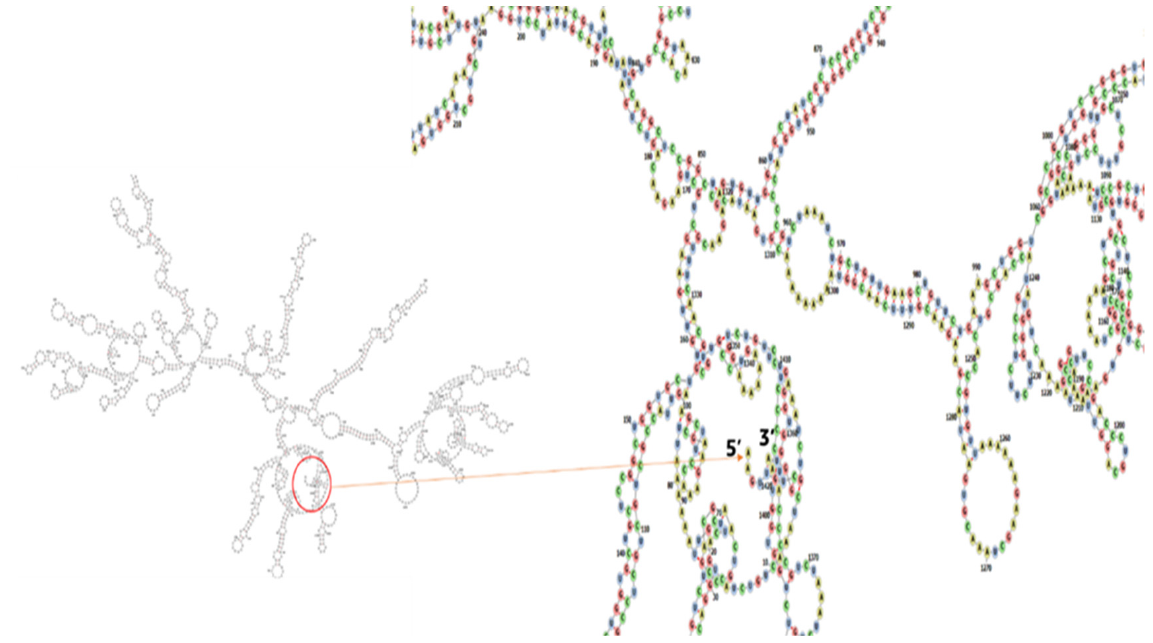
Figure 15. The vaccine’s predicted secondary structure of mRNA. There are no pseudoknots or hairpins at the 5 ′ end of the projected mRNA structure.